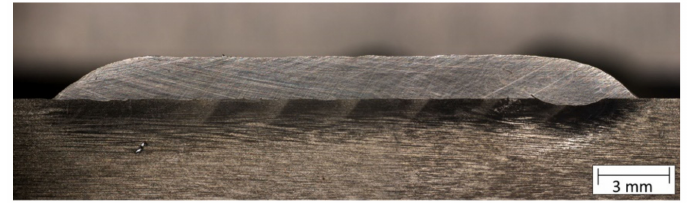
Figure 3. Cross-section of the welding coating with even surface and minimal dilution.